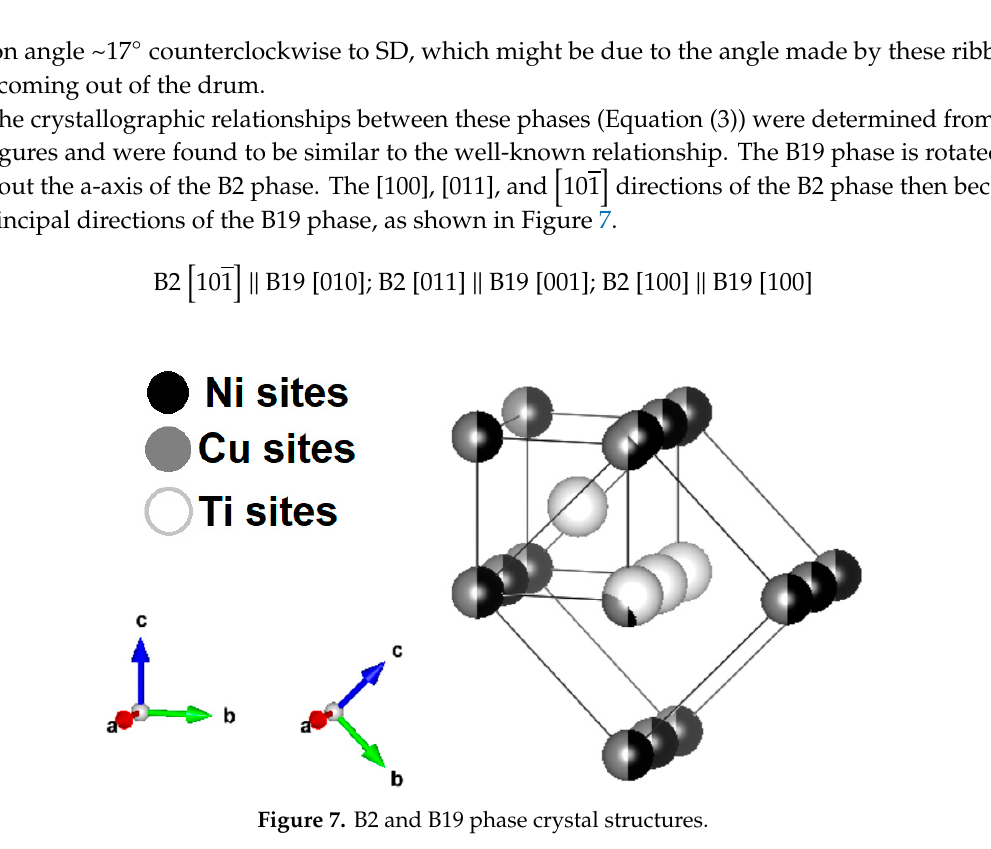
Figure 6. Wheel-side pole figures of R60 and R96 ribbons with spinning (SD) and transverse directions (TD) as reference.